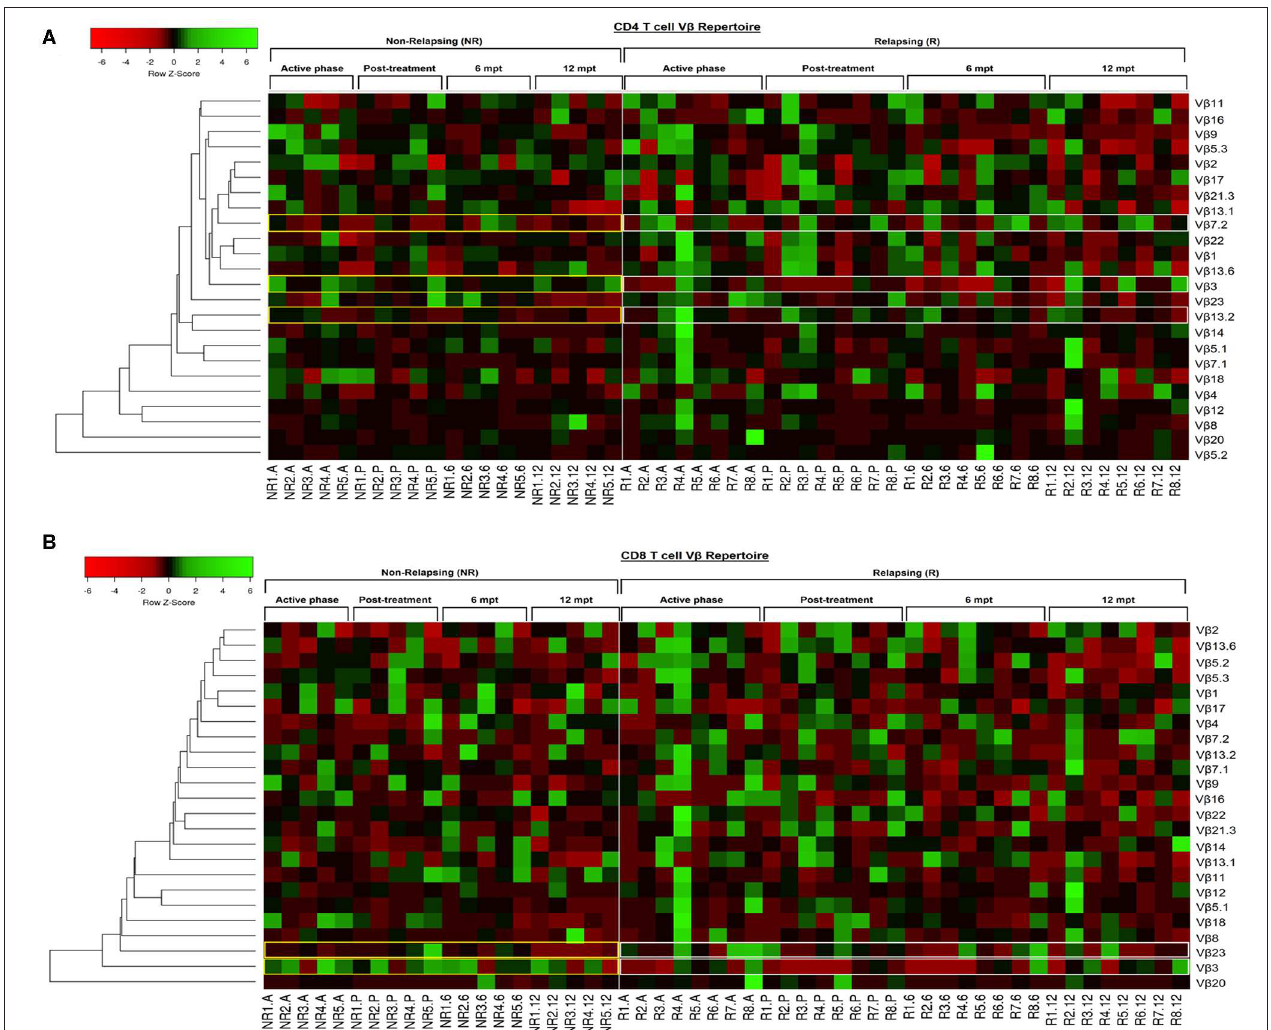
FIGURE 3 | Individual pattern of V β repertoire mobilization on CD4 + and CD8 + T cells of the visceral leishmaniasis/HIV (VL/HIV) co infected patients during all the follow-up by heatmap analysis. To this analysis, the mobilization index was calculated so that the percentage of a given V β family presented by each VL/HIV patient was divided by mobilization mean of this V β family presented by healthy subjects. Each V β family is demonstrated in the line ( n = 24) and each VL/HIV patient is represented in the column (NR- 1 to 5; R- 1 to 8) during all phases of follow-up (A, P, 6 and 12). The V β families were clustered in accordance with the similarity, using appropriate distance and clustering methods. The red and green scales represent a lower and higher mobilization index, respectively, of a given V β family on CD4 + T (A) and CD8 + T (B) cells for each VL/HIV patient seen individually. Active phase (A); Early post-treatment (P); 6 months post-treatment (6; 6 mpt); 12 months post-treatment (12; 12